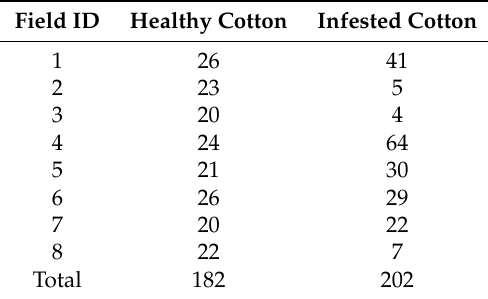
Table 1. The number of sample points in healthy and infested cotton areas for Fields 1–8. Field ID